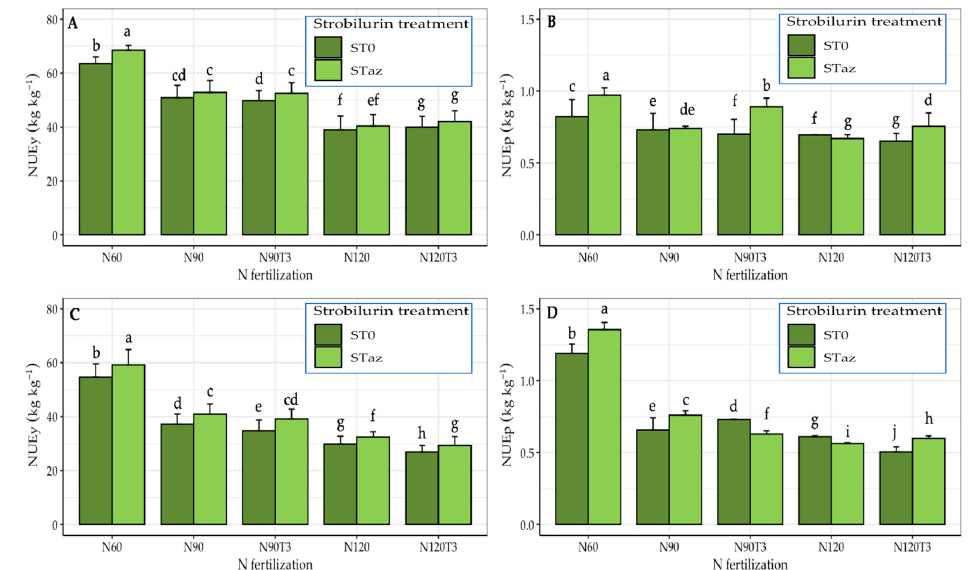
Figure 3. Effect of the interactions between nitrogen fertilization and strobilurin treatment for nitrogen use efficiency for yield (NUEy, ( A ) and ( C ) in 2011 and 2012, respectively) and nitrogen use efficiency for protein (NUEp, ( B ) and ( D ) in 2011 and 2012, respectively). N60, N90 and N120 correspond to 60, 90 and 120 kg ha − 1 of nitrogen applied two times; N90T3, 90 kg ha − 1 of nitrogen applied three times; N120T3, 120 kg ha − 1 of nitrogen applied three times. ST0, no strobilurin treatment; STaz, strobilurin treatment. Values followed by different letters are significantly different at p ≤ 0.05 according to Tukey’s test. Vertical bars indicate standard errors ( n = 6).